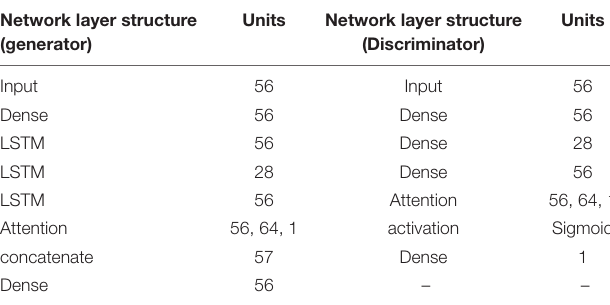
TABLE 1 | LA-CycleGAN network layer structure